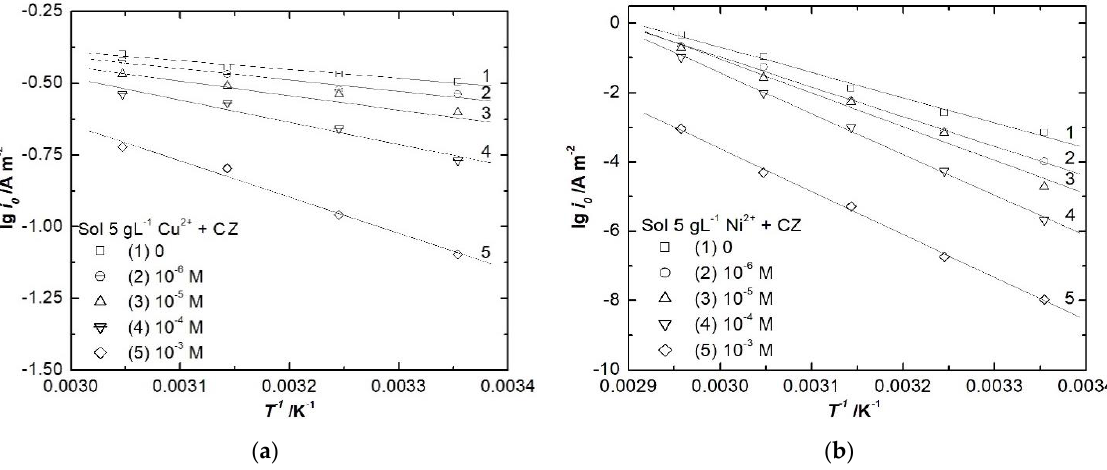
Figure 6. Arrhenius plots for copper ( a ) and nickel ( b ) deposition without and with different concentrations of CZ. Table 3. Activation energy values for copper and nickel electrodeposition without and with different concentrations of CZ.